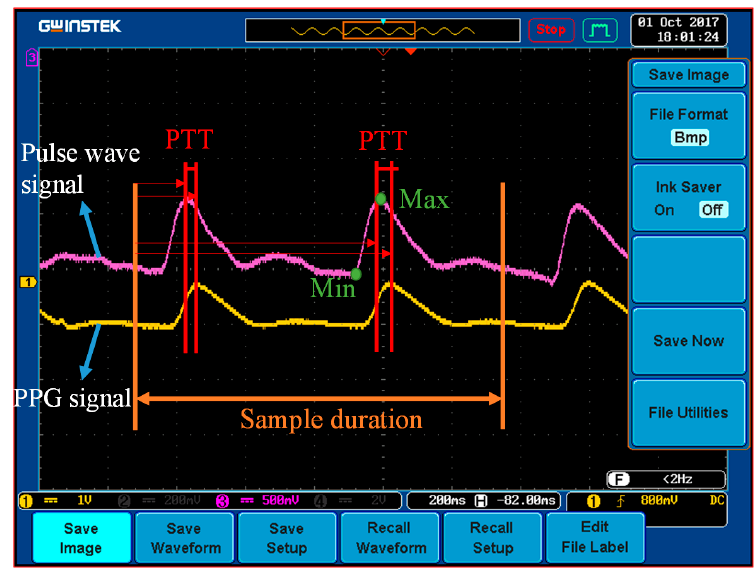
Figure 12. Photograph of an oscilloscope display featuring PPG and pulse wave signals.